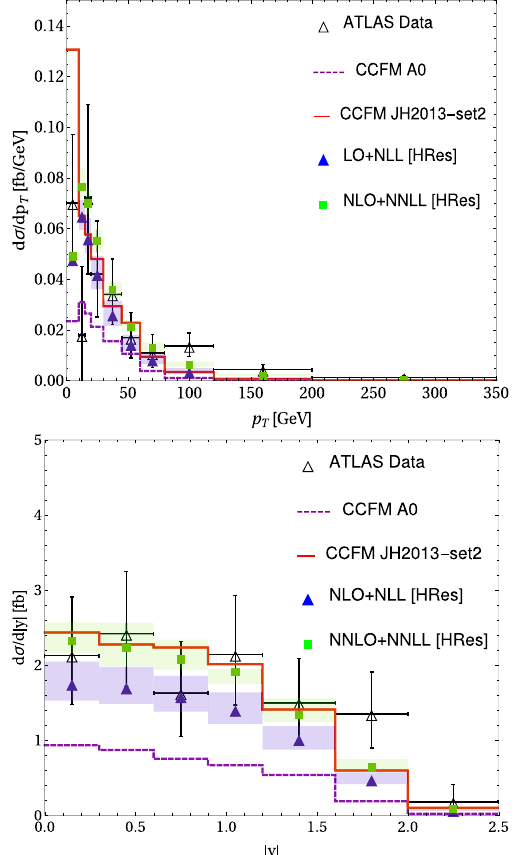
Fig. 3 Differential cross section of the Higgs boson production as a Fig. 4 Differential cross section of the Higgs boson production as a function of transverse momentum ( p T ) and rapidity ( y ) of the Higgs √ function of transverse momentum ( p T ) and rapidity ( y ) of the Higgs √ S = 8 TeV. Notations of all boson in four-lepton decay channel at S = 13 TeV. Notations of all boson in four-lepton decay channel at the histograms are the same as in fig. 2. Higher order pQCD predictions thehistograms arethesameas inFig. 2. Higherorder pQCDpredictions up to NNLO + NNLL accuracy are obtained using HRes tool [28,76]. up to NNLO + NNLL accuracy are obtained using HRes tool Experimental data points are from CMS [63]